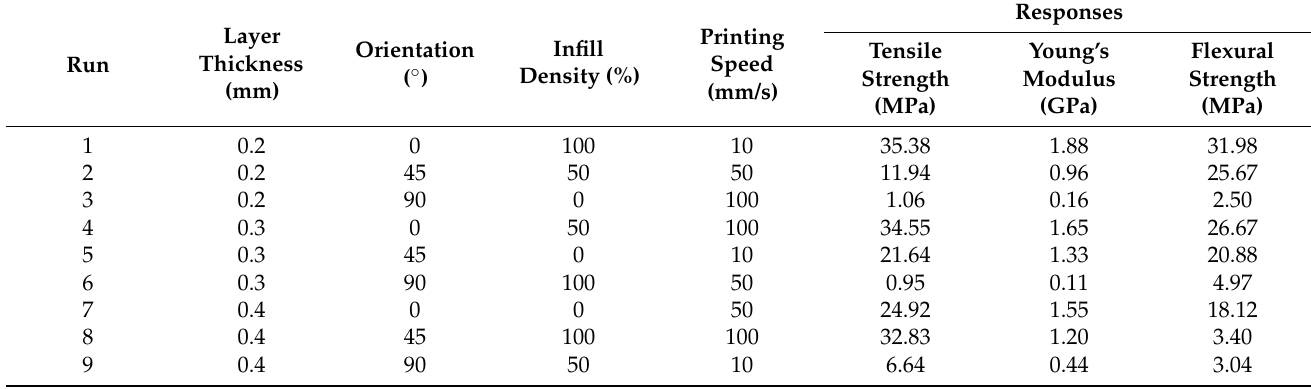
Table 2. Orthogonal array design L 9 (3 4